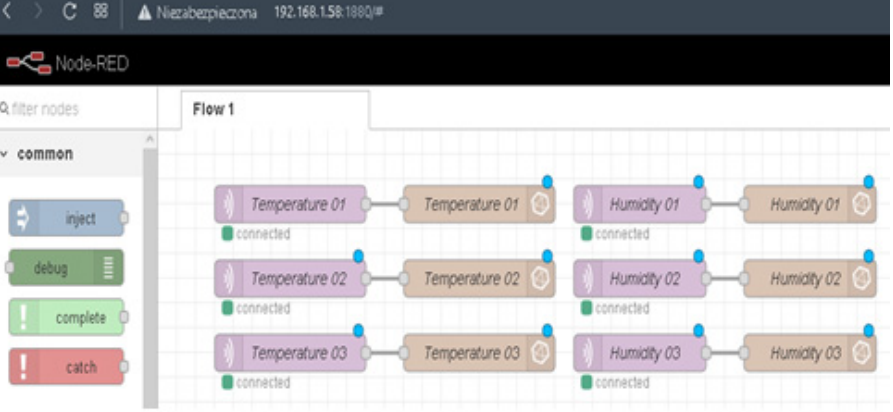
Figure 8. Node—Red, own study A. Wycisk.